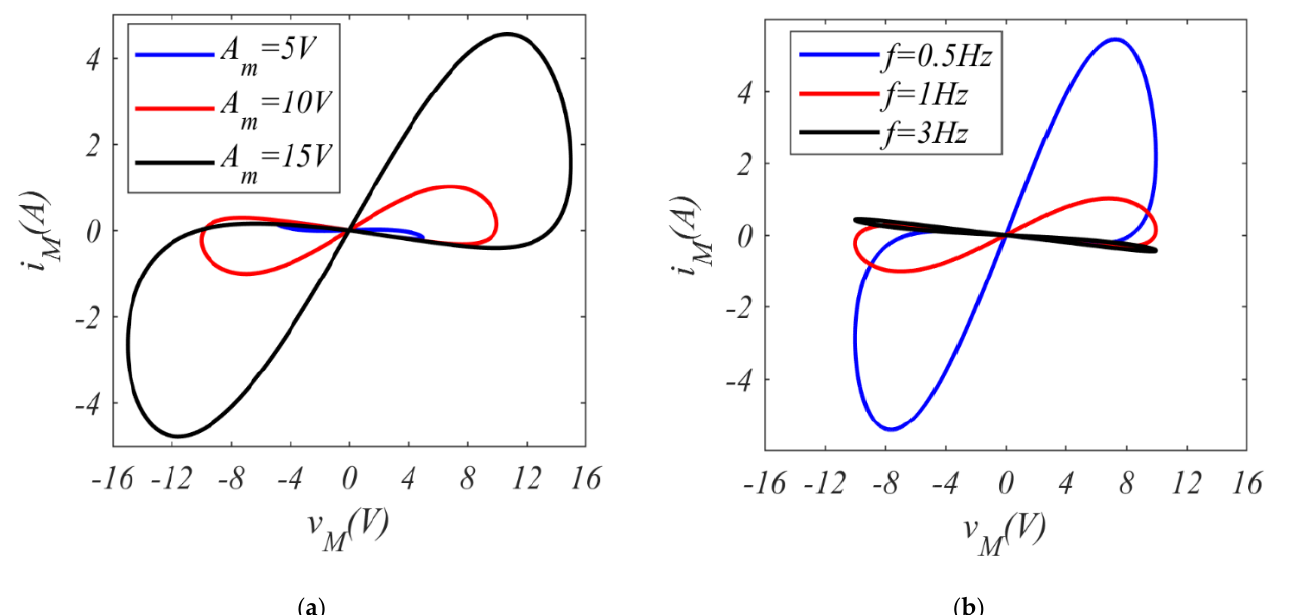
Figure 1. v M − i M characteristics of memristor (6): ( a ) with f = 1 Hz and different amplitudes; ( b ) with A m = 10 V different frequencies.